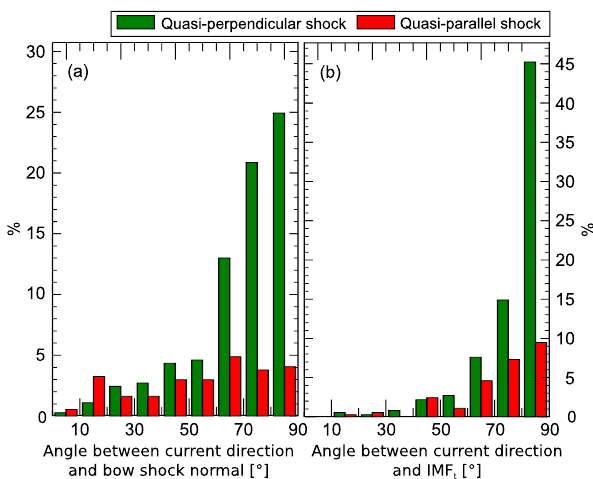
Figure 5. Frequency distribution of the angle difference between the current directions and the local bow shock normal (a) and the IMF tangential component (b) . The angles are binned with 10 ◦ in-